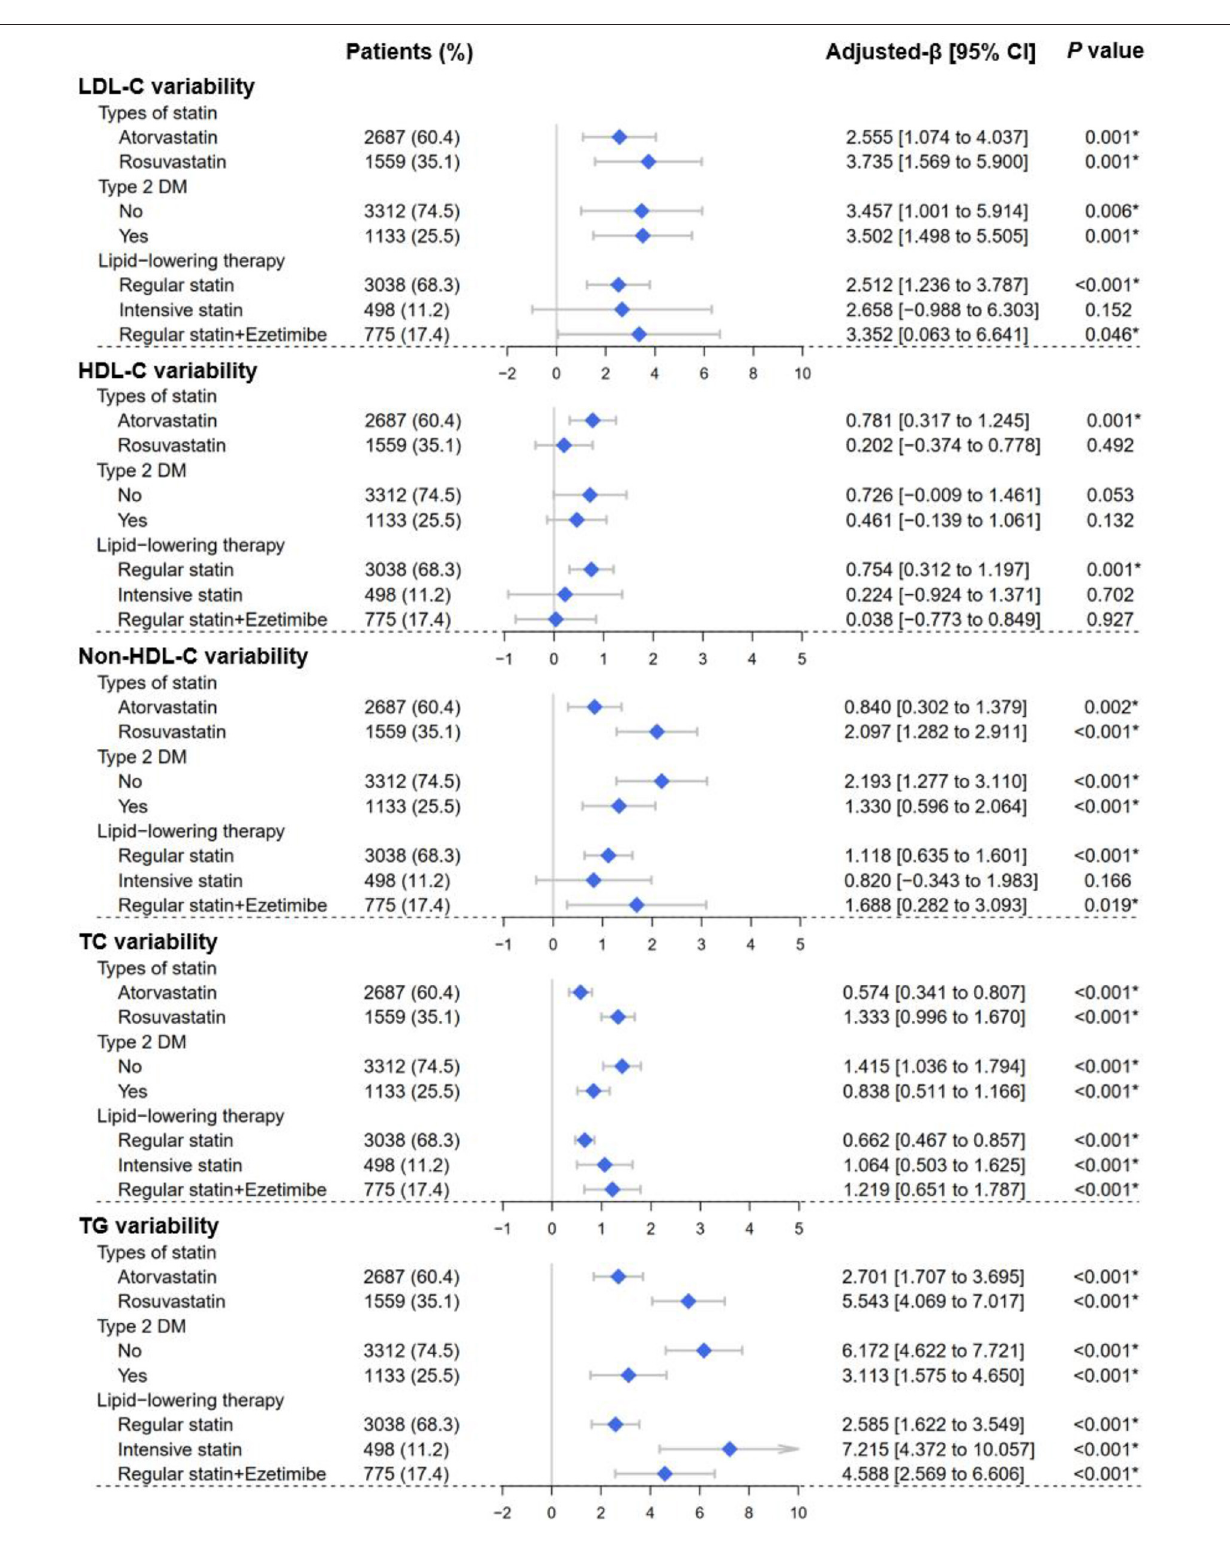
Frontiers in Cardiovascular Medicine |